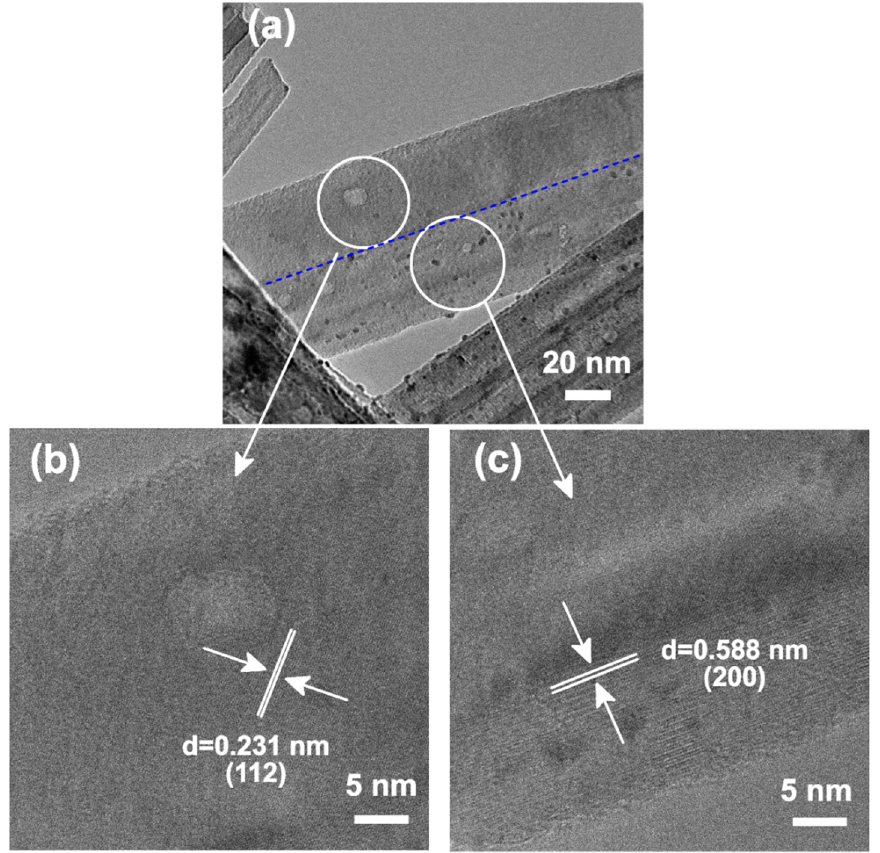
Figure 6. TEM images of a nanoparticle with a heterostructure ( a ) in the Pt-deposited TiO 2 MP sam- ple (with 1.2 wt% Pt 4+ loading amount). HRTEM images of ( b ) upper and ( c ) lower areas, as indi- cated in ( a ).